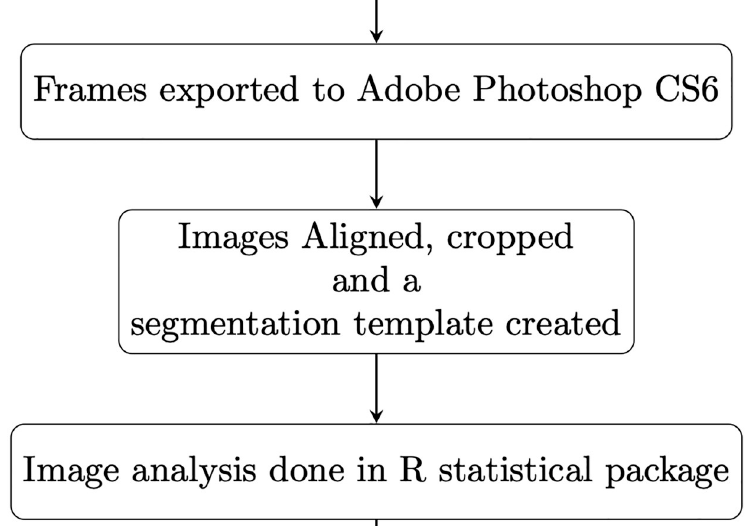
(IQR) were used to measure data dispersion. The Kruskal-Wallis test was used to assess the sta- tistical significance between the median HRW ized using logarithmic transformation, which is a recommended transformation for data skewed to the right [62]. In addition, Pearson’s criteria for normality were used to confirm the appropriate transformation, these values were HRW